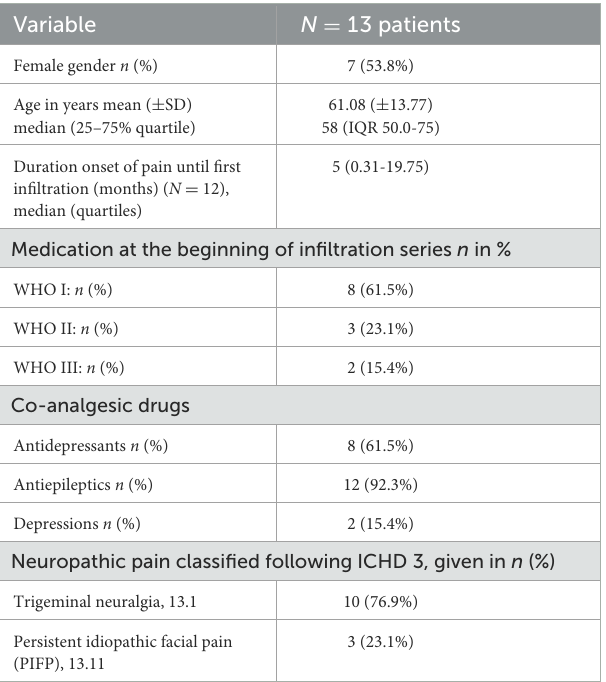
TABLE 1 Basic characteristics for N = 13 patients included with refractory neuropathic pain syndromes in the head-neck